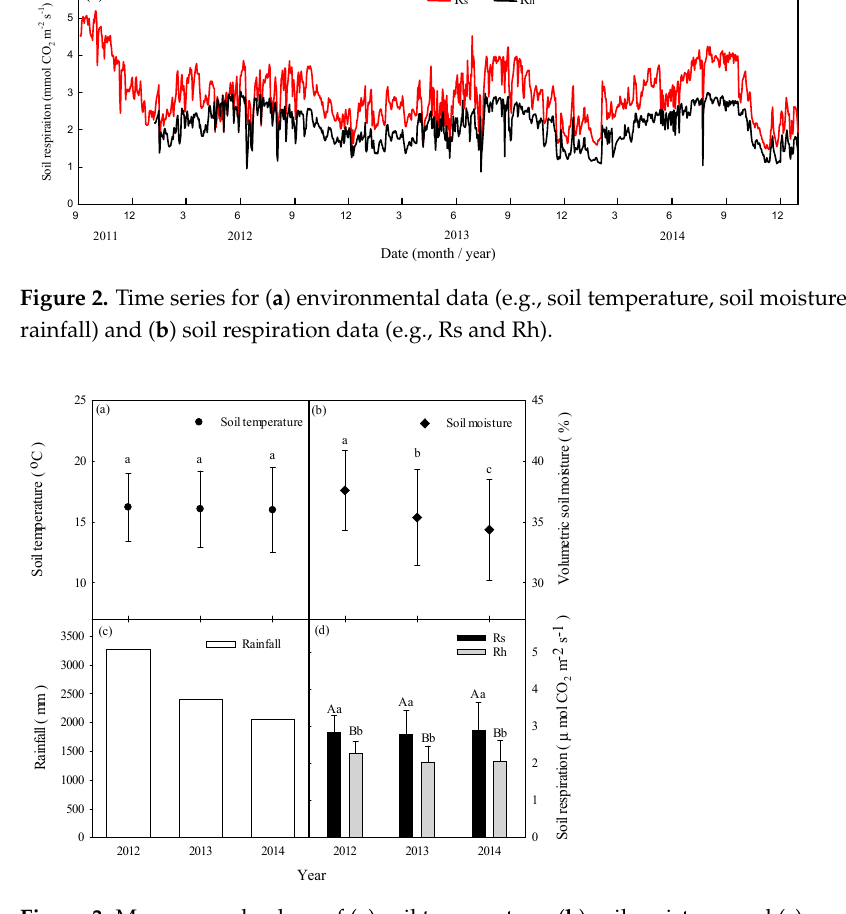
Figure 3. Mean annual values of ( a ) soil temperature, ( b ) soil moisture, and ( c ) annual rainfall and mean annual values of ( d ) soil respiration (Rs) and heterotrophic respiration (Rh). Different capital letters indicate differences among treatments within the same year at p < 0.05. Different lowercase letters indicate differences among years at p < 0.05. Error bars indicate standard deviations (SD).